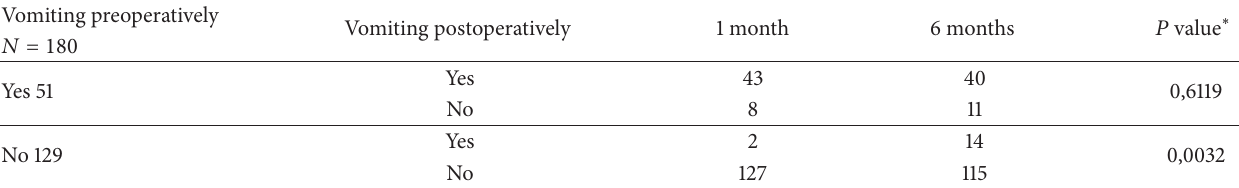
∗ Statistical method: Fisher’s exact probability test.